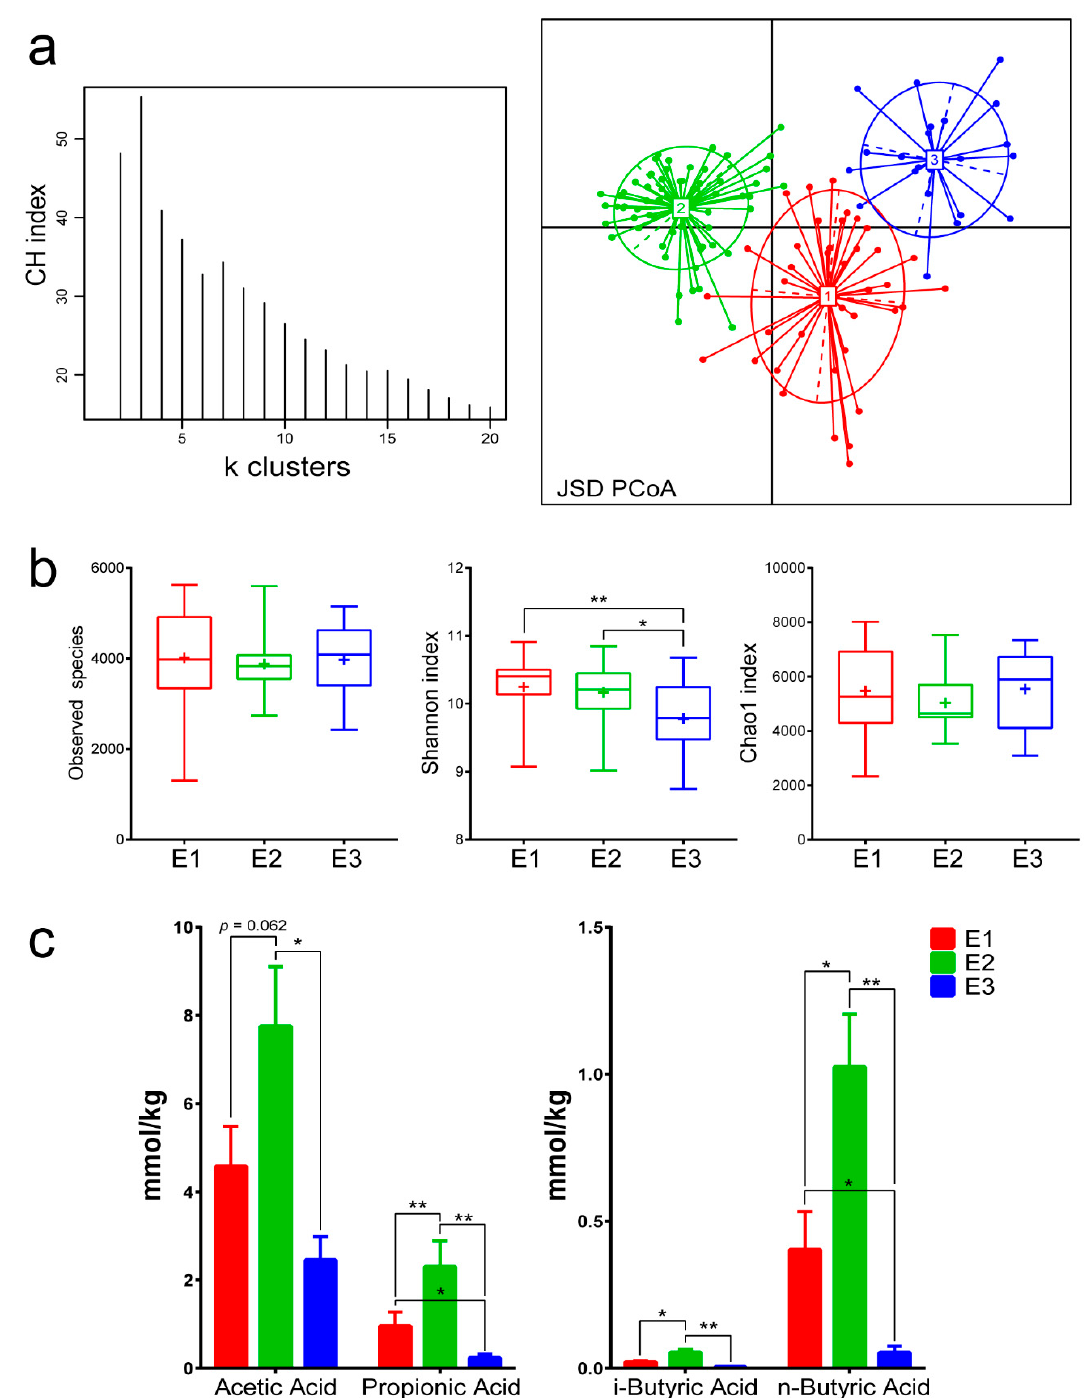
Figure 1. Identification of enterotypes in pika. ( a ) Calinski-Harabasz (CH) indices for a number of enterotypes and principal coordinate analysis (PCoA) analysis based on Jensen–Shannon distance (JSD) dissimilarity. ( b ) Alpha diversity (observed species, Shannon index, and Chao1 index) of the three enterotypes. Di ff erences were assessed by the Kruskal–Wallis test and denoted as follows: * p < 0.05; ** p < 0.01. ( c ) Four major short-chain fatty acids (SCFAs) (mean ± SE) of the three enterotypes. Di ff erences were calculated by one-way analysis of variance (ANOVA) and are denoted as follows: * p < 0.05; ** p < 0.01.